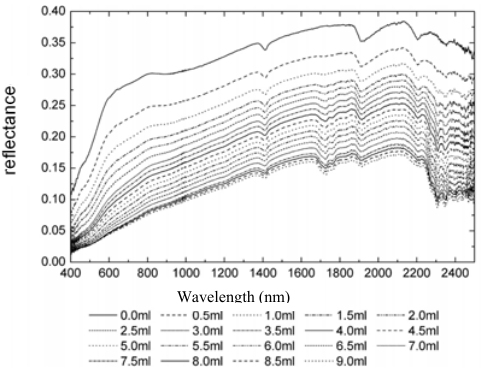
Figure 1. Comparison of different amount of crude oil in soil